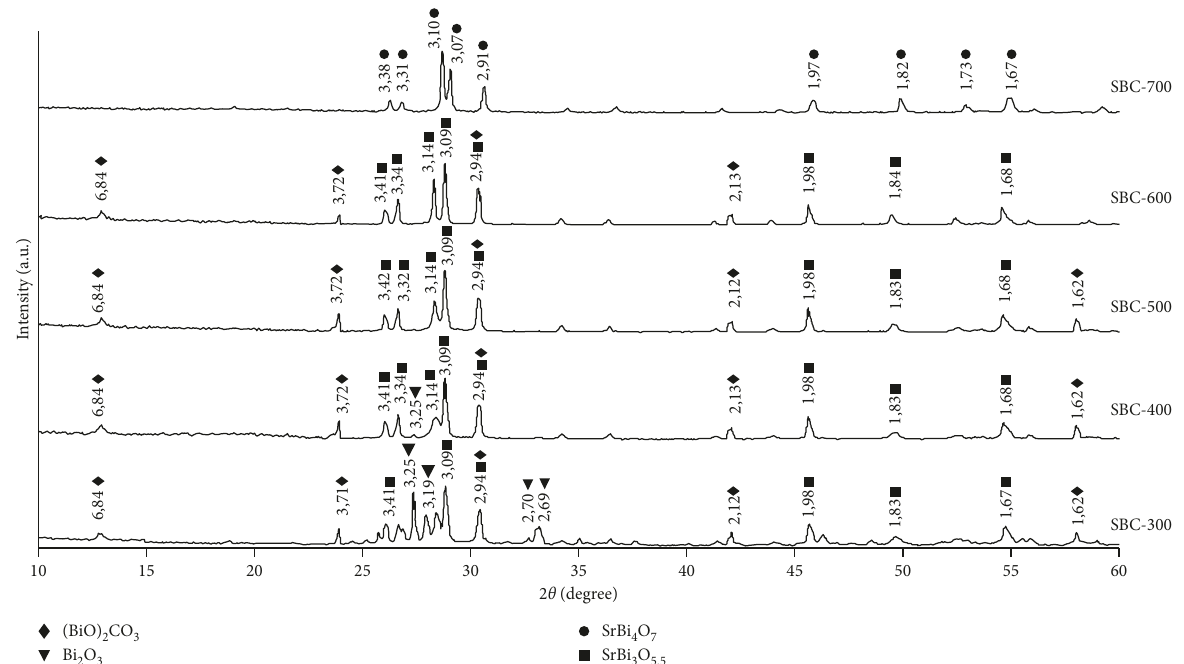
Figure 1: XRD patterns of samples obtained at different synthesis